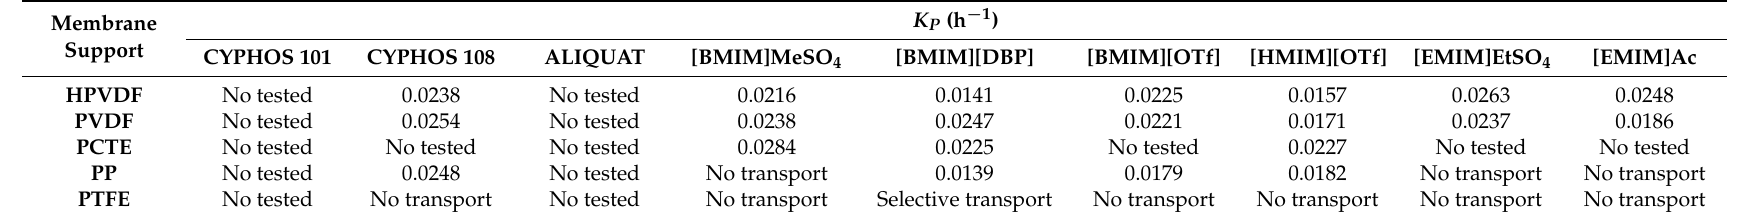
Table 3. Summary table with the values of effective mass transfer constants K P of the different tested